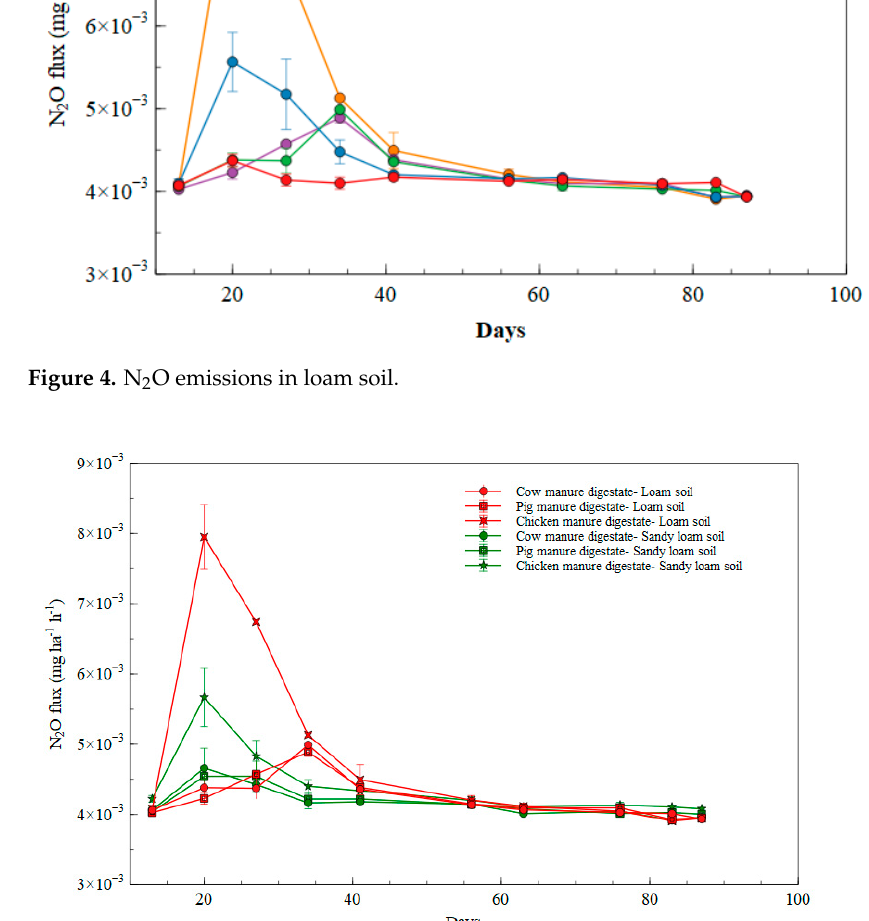
Figure 6. Chlorophyll Index measurement in loam soil fertilized treatments.